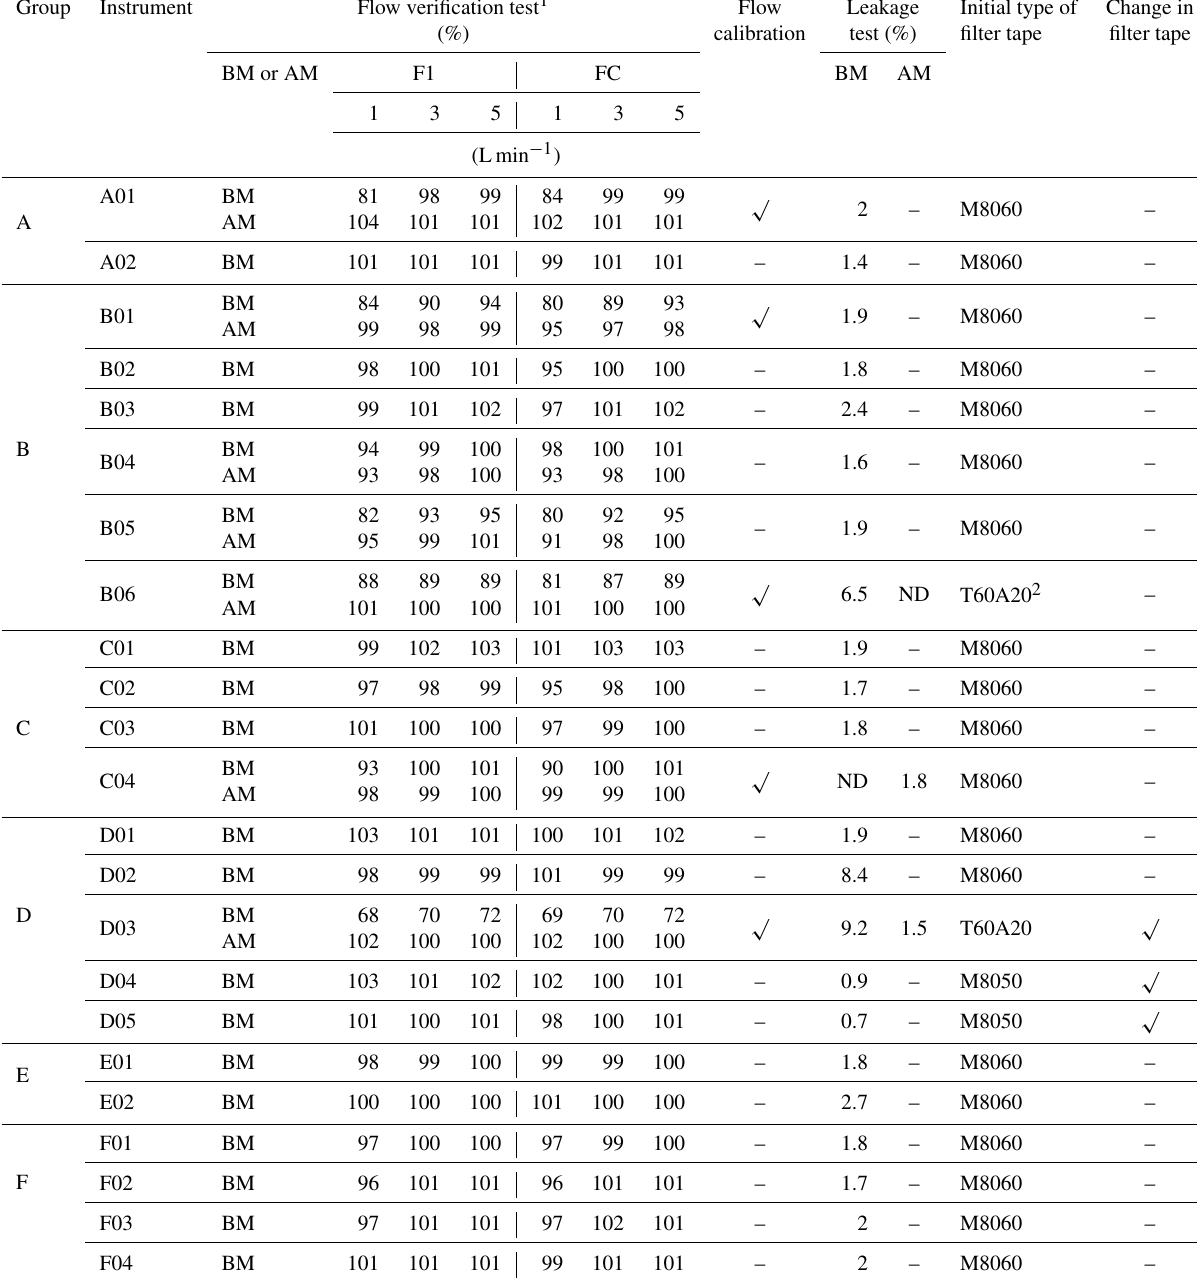
Table 3. Summary of results from maintenance tests.